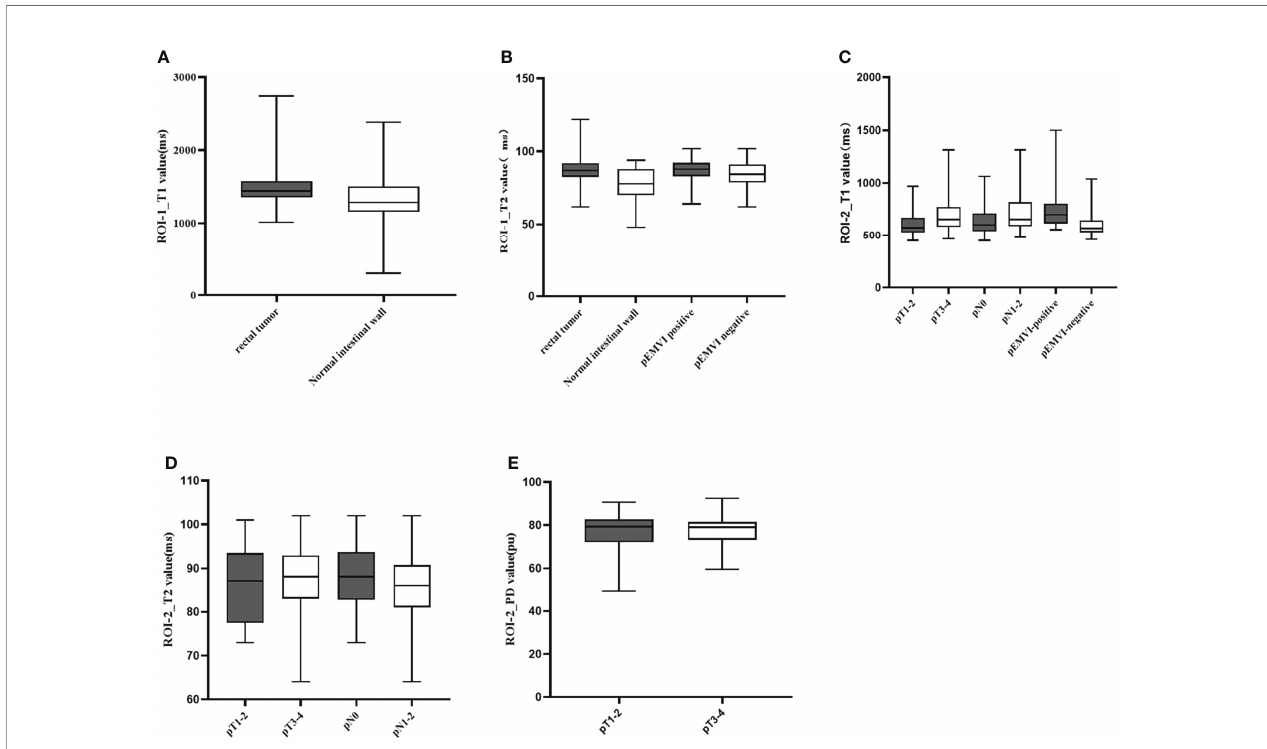
FIGURE 5 | Box-and-whisker plots of T1, T2 values in ROI-1 and T1,T2,and PD values in ROI-2.T1 values of ROI-1 based on rectal tumor (A) ; T2 values of ROI-1 based on rectal tumor and extramural venous invasion (EMVI) (B) ; T1 values of ROI-2 based on different T stage, N stage, and EMVI (C) ; T2 values of ROI-2 based on different T stage and N stage (D) ; PD values of ROI-2 based on different T stage (E) . Signi fi cant differences were found between the two groups (all p <